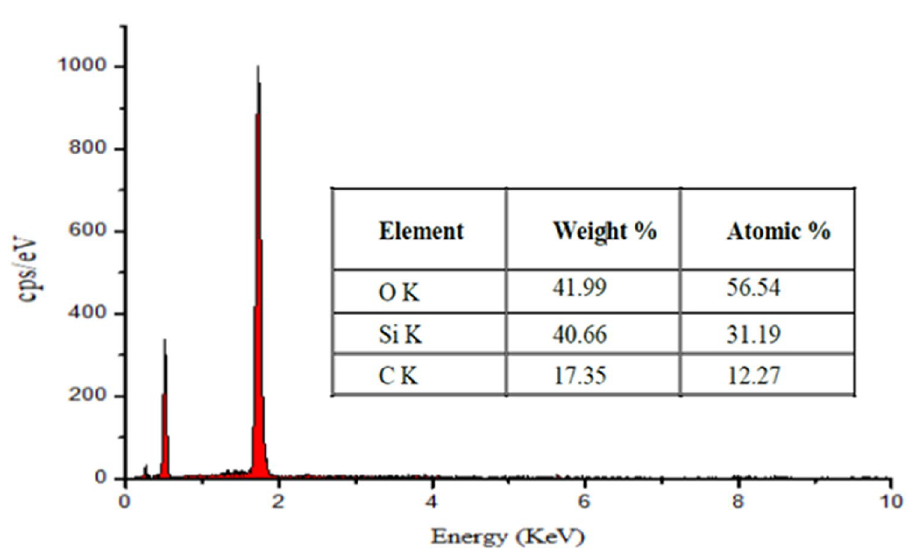
Figure 6. Energy dispersive spectroscopy (EDS) for